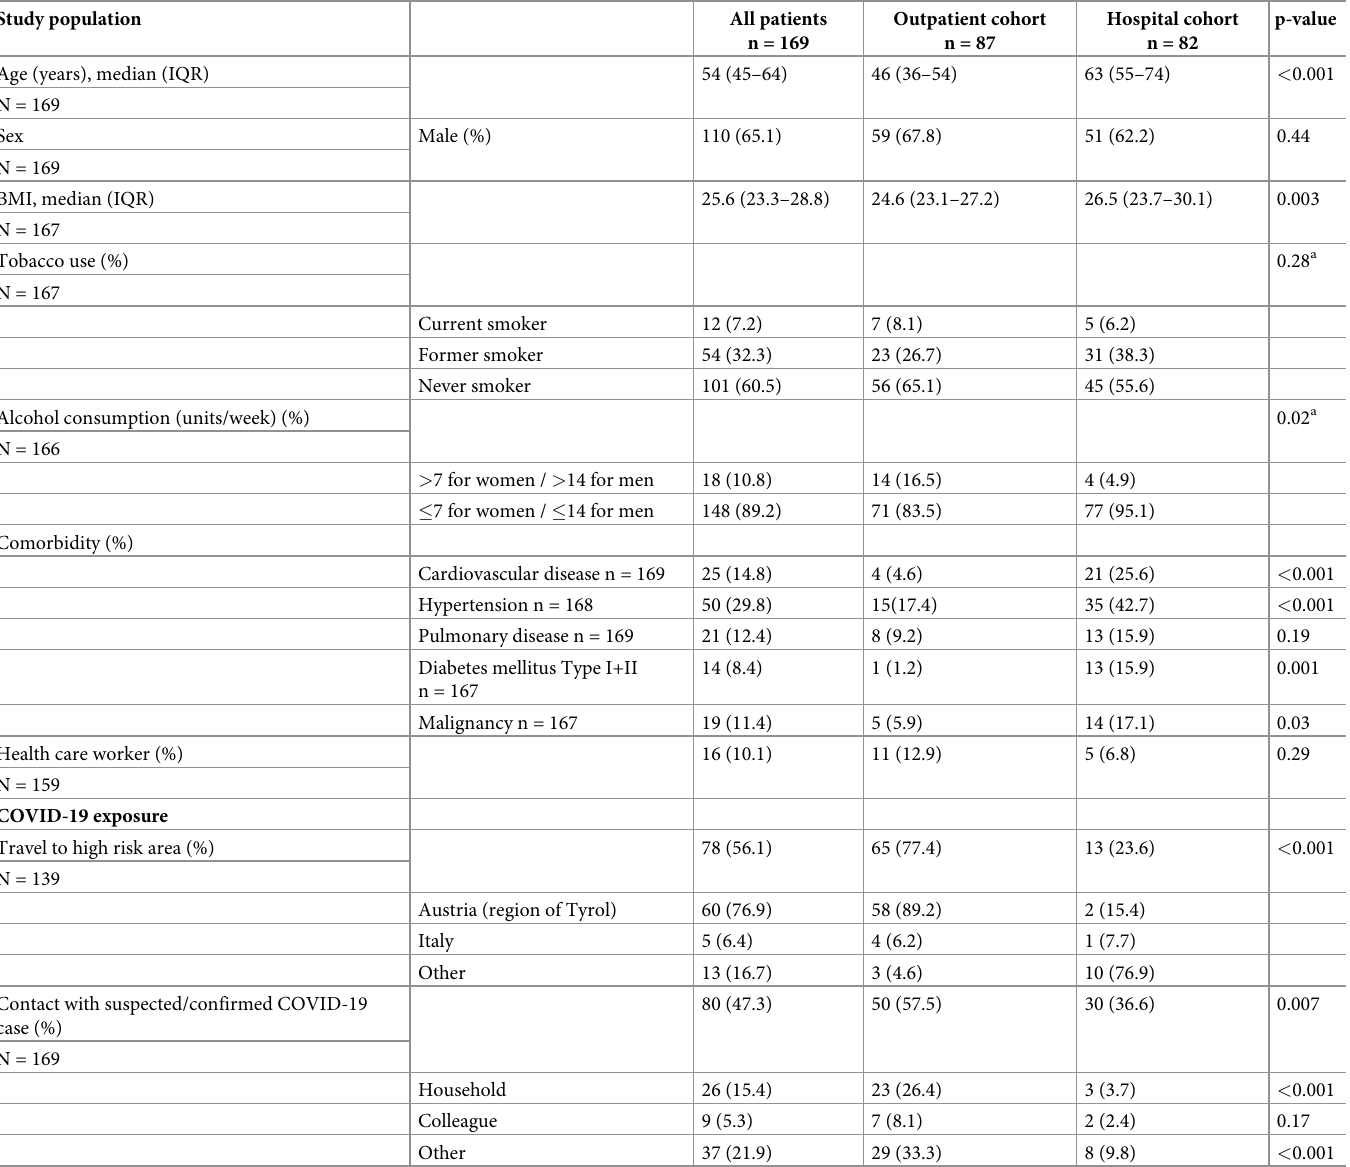
Table 1. Characteristics and exposures in a Danish outpatients and hospitalised patients with COVID-19. Study